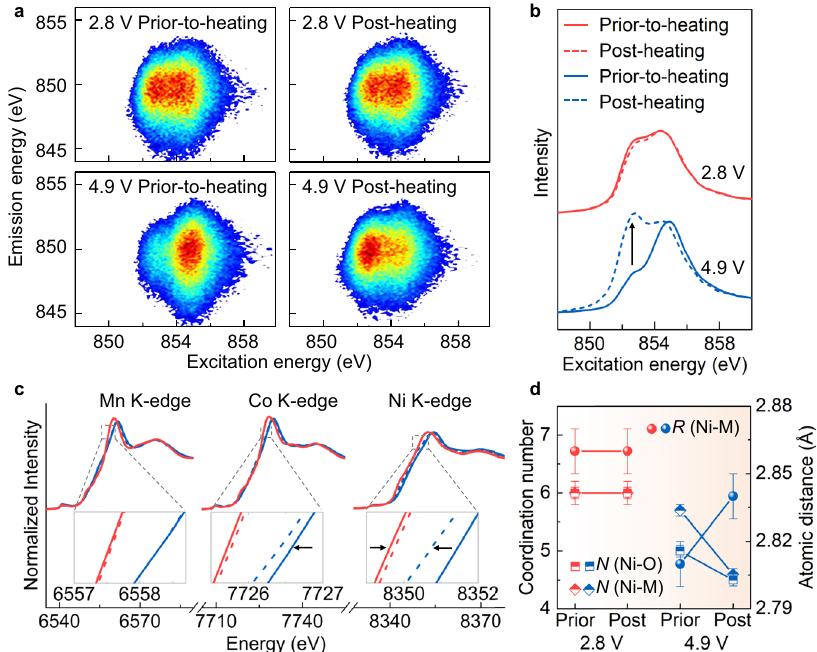
Fig. 2 Evolution of the electronic and atomic structures in single-crystalline electrodes. a RIXS maps of the 2.8 and 4.9 V electrodes collected at Ni L 3 - edge before and after thermal treatment. b The PFY spectra extracted from the RIXS maps for the 2.8 and 4.9 V electrodes before and after thermal treatment. c The XANES spectra were recorded at Ni, Co, and Mn K-edges for the 2.8 and 4.9 V electrodes before and after thermal treatment. The curve name in ( c ) is identical to ( b ). d The coordination number and bond length of the 2.8 and 4.9 V electrodes before and after thermal treatment.